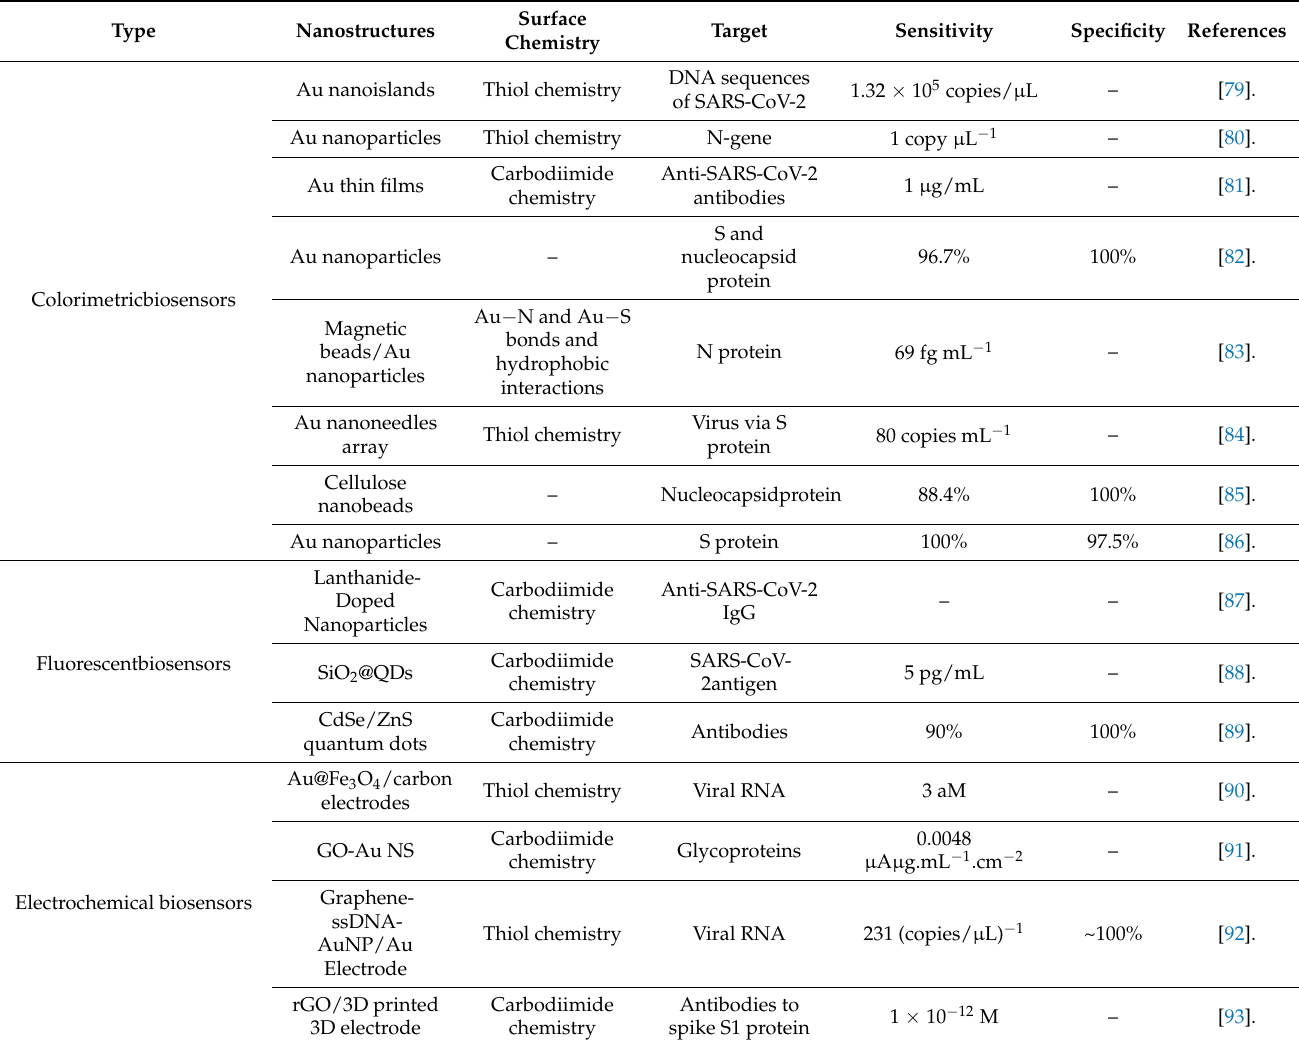
Table 2. Summary of responsive nanostructures in biosensing of the